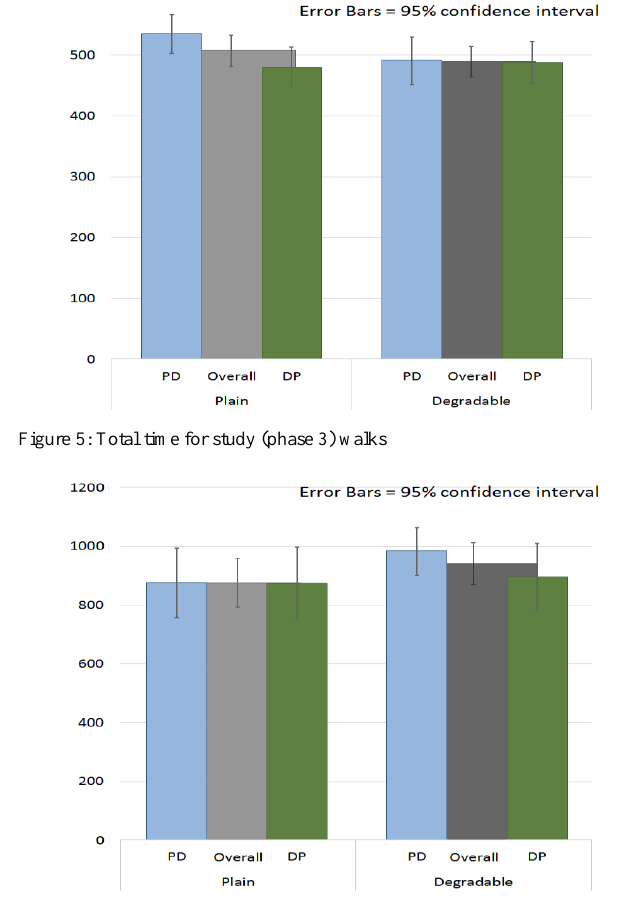
Figure 6: Number of steps taken during the walks